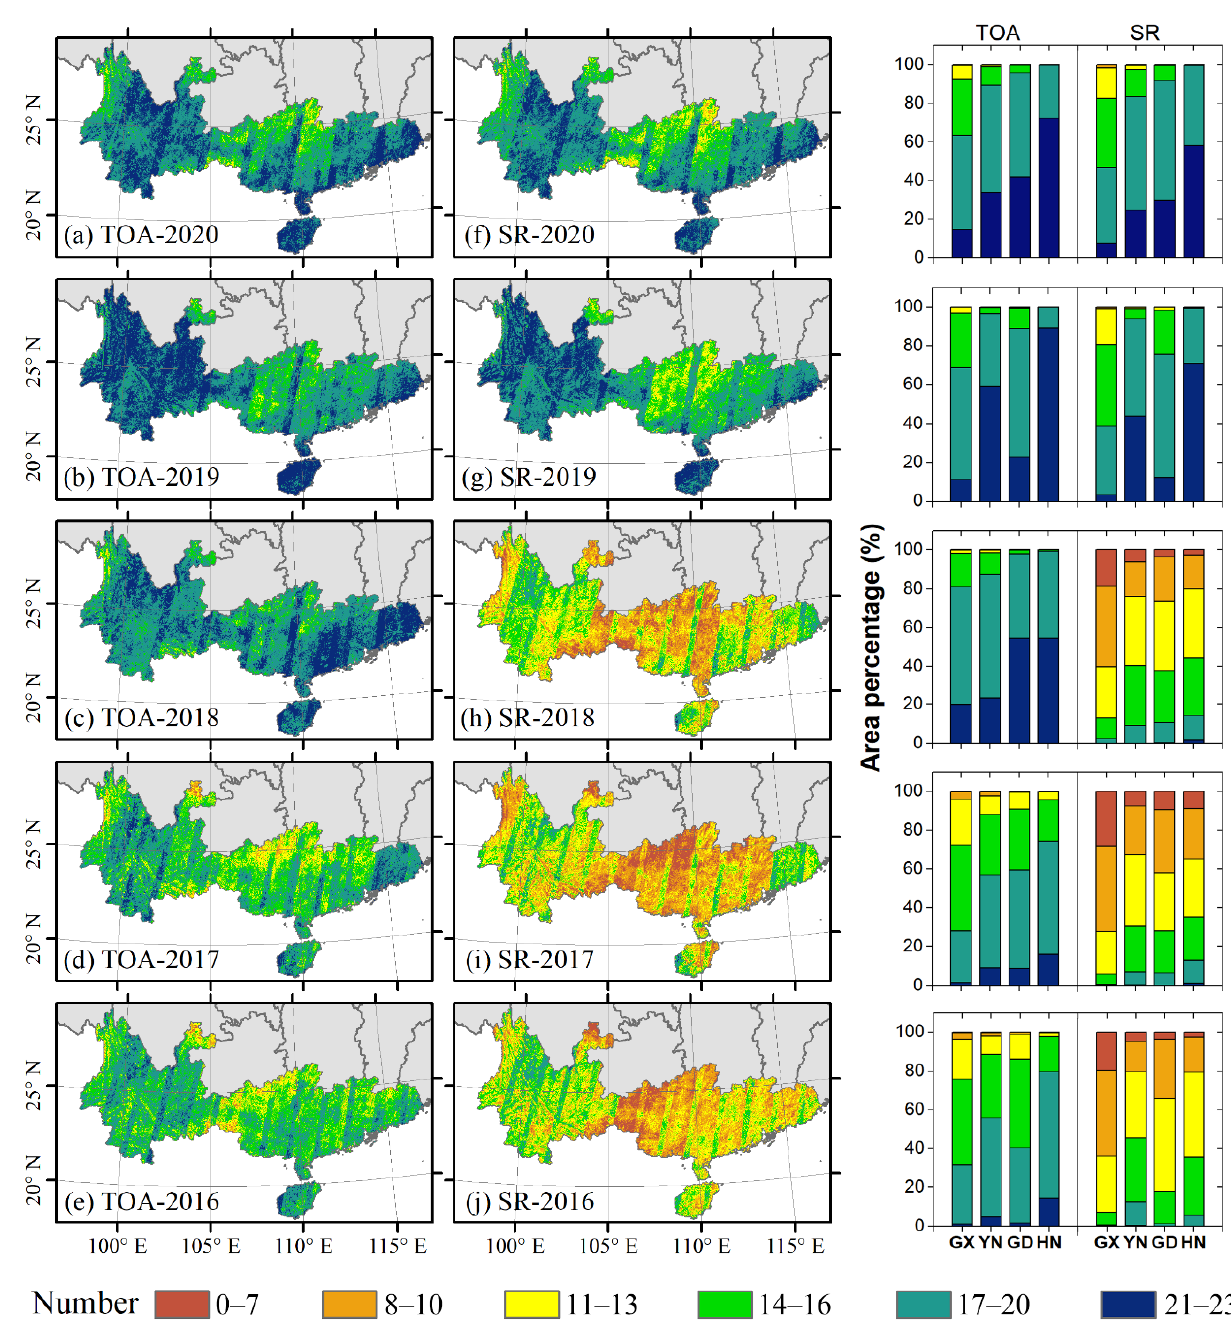
Figure 2. Number of high-quality observations for the 16-day composite top of atmosphere reflectance (TOA) and surface reflectance (SR) data from 2016 to 2020.